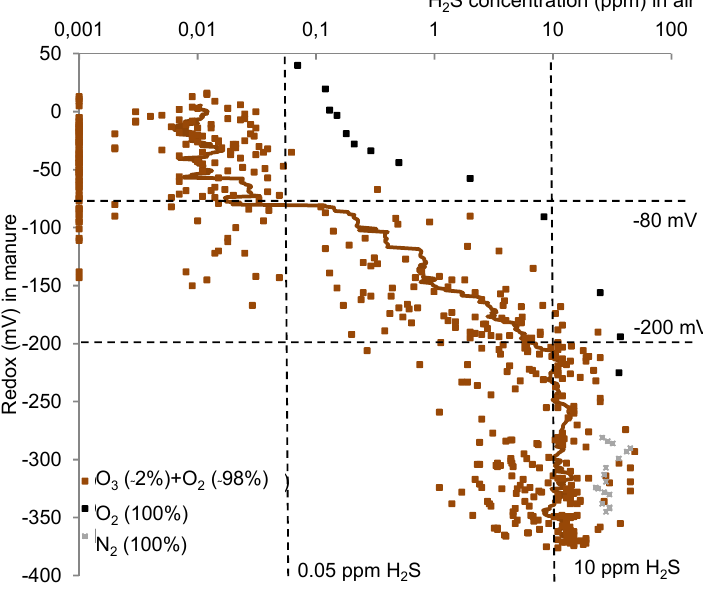
Figure 3. Decrease in gaseous hydrogen sulfide concentrations as a function of redox potential for N (n = 1), O (n = 1) and all O treatments (n = 2 2 3